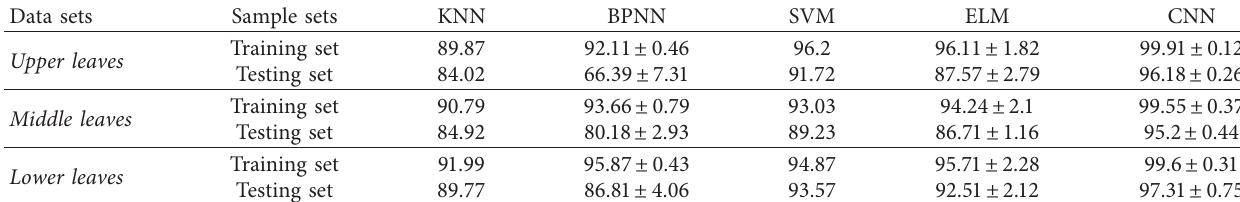
Table 6: The prediction results (%) of convolutional neural networks and other four methods. Data sets